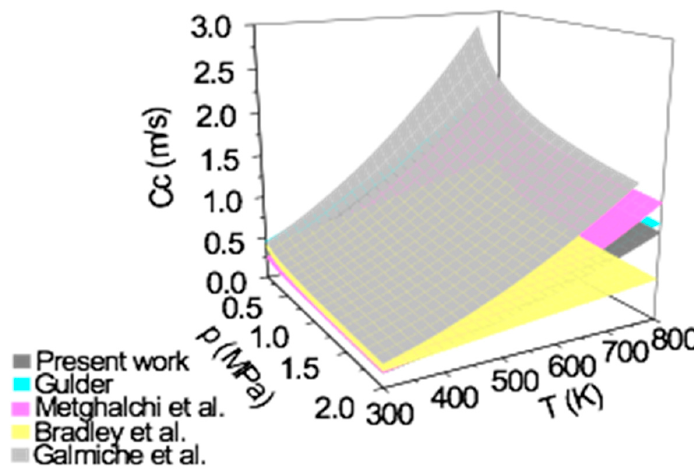
Figure 6. The burning velocity of iso-octane as a function of temperature and pressure for the stoichiometric equivalence ratio. Comparison between the expressions obtained by Gülder [6], Metghalchi and Keck [8], Bradley et al. [7], Galmiche et al. [9] and those obtained in the present work.